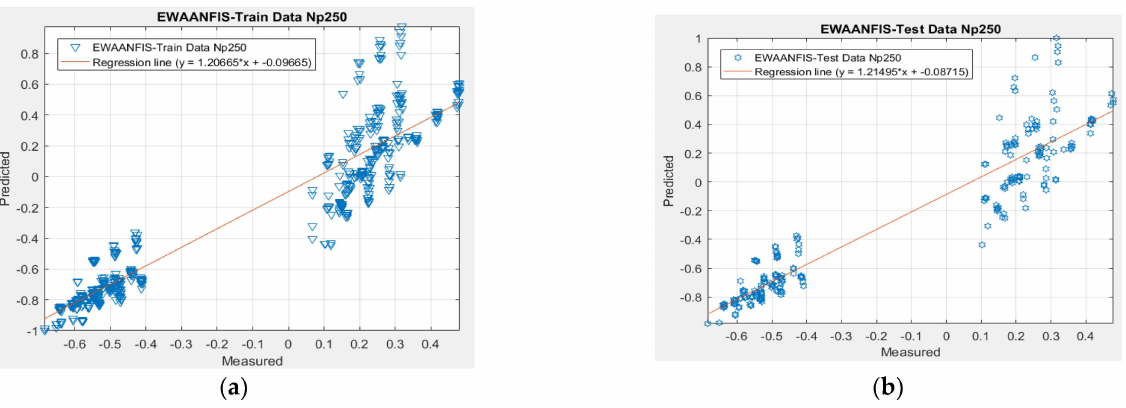
Figure 6. The accuracy of training and testing dataset performance of EWA − ANFIS in the best-fit optimization structure: ( a ) EWA − ANFIS train Np = 250; ( b ) EWA − ANFIS test Np =